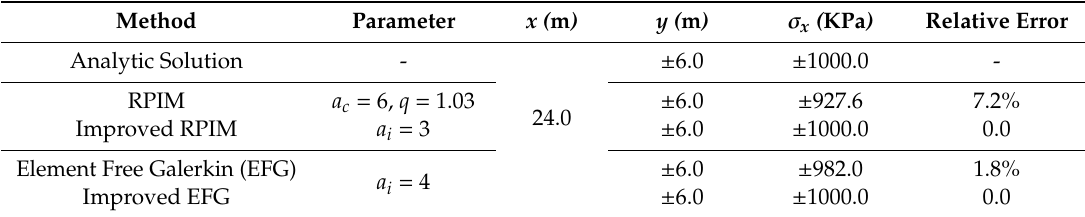
Table 1. The stress solutions obtained from di ff erent methods at coordinate position (24 m, 6